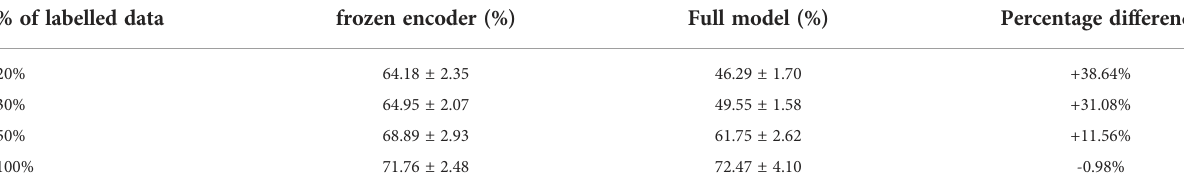
TABLE 9 The DSC segmentation performance using the medium-scale dataset for SSL-trained encoder vs. full model. % of labelled data